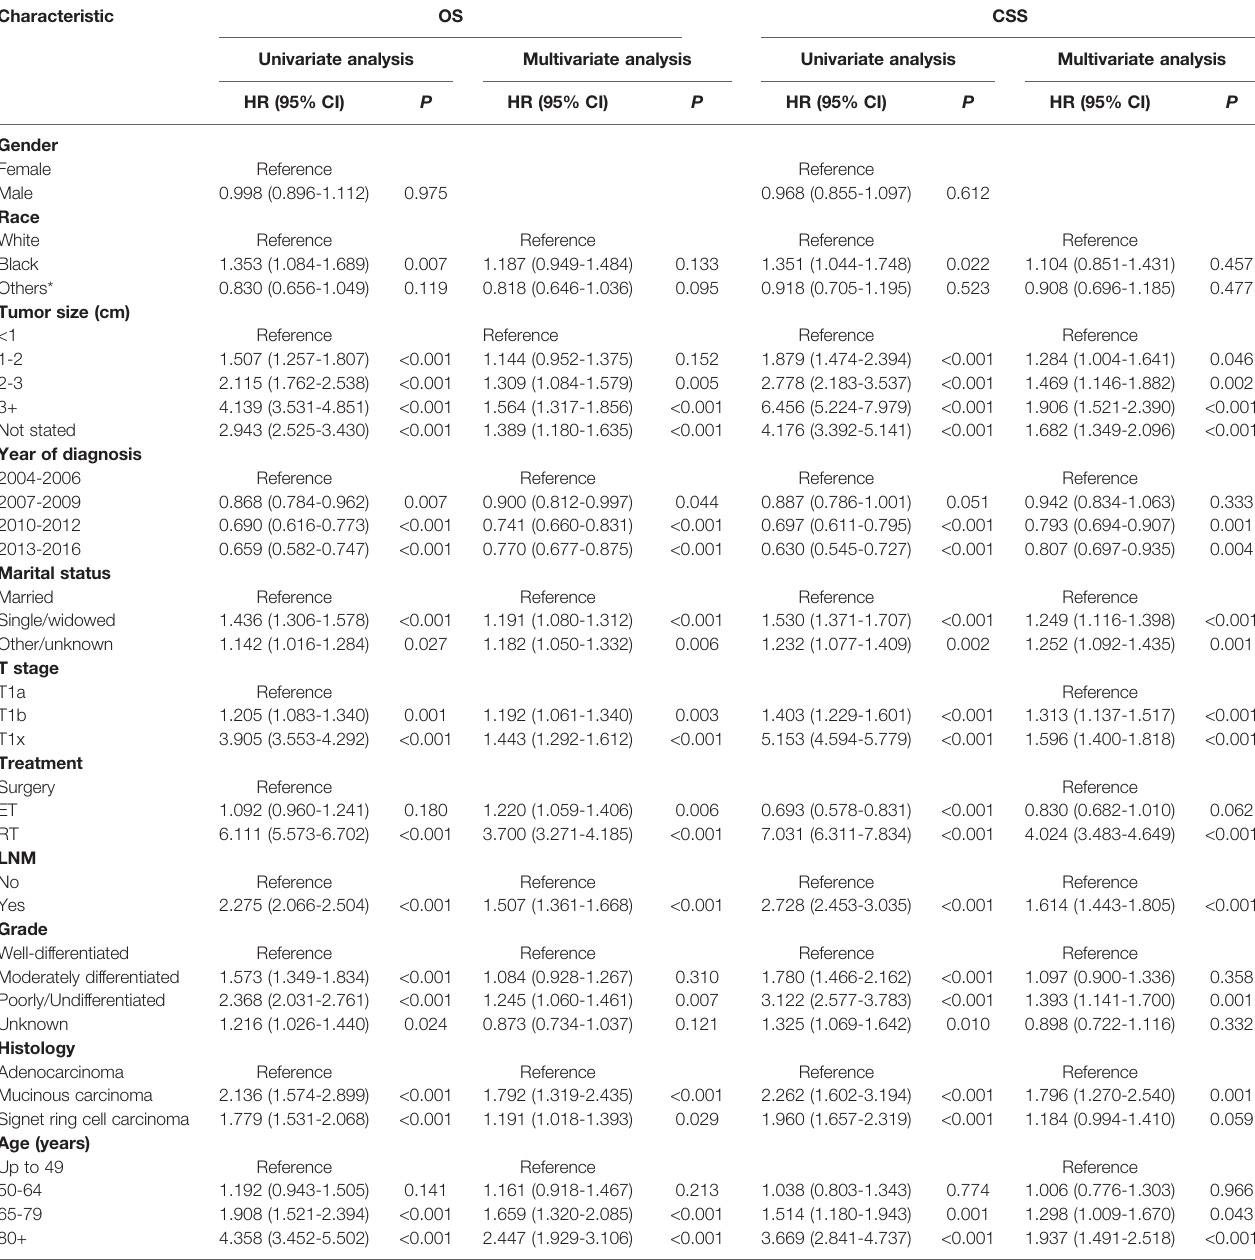
TABLE 4 | Cox regression analysis of OS and CSS in patients with early-stage esophagogastric junction cancer. Characteristic